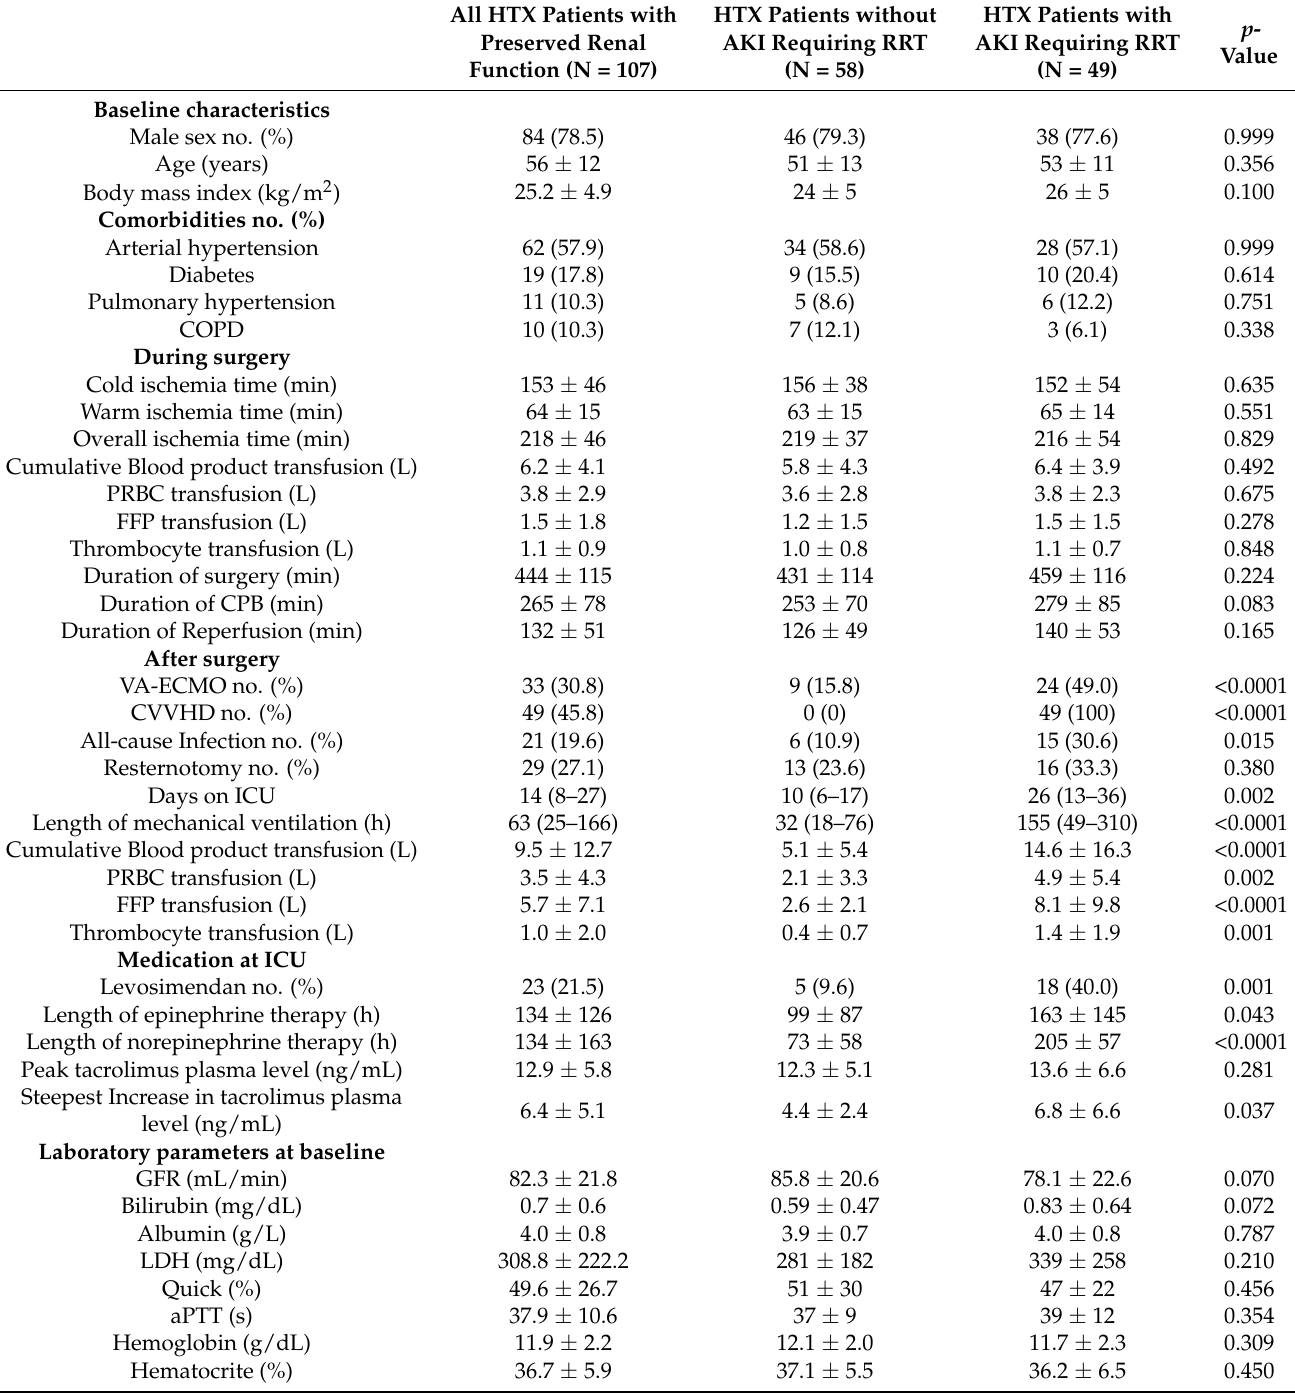
Table 1. Patient